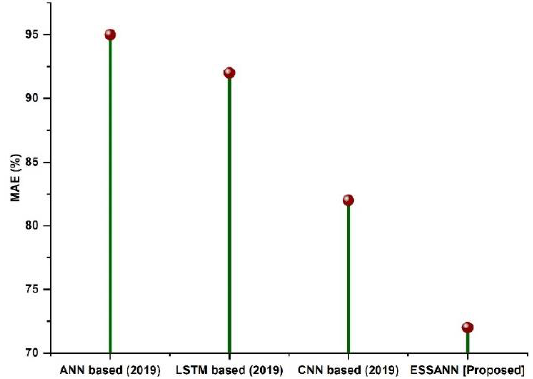
Figure 10. Comparison of